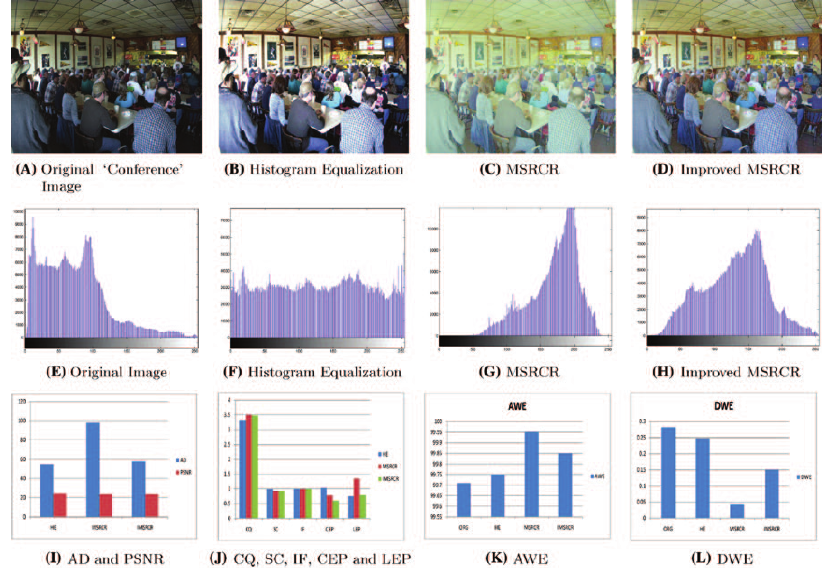
Figure 9. (Top) Image Enhancement Methods. (Middle) Histogram Plots: x -axis, Intensity Levels Ranging from 0 to 255; y -axis, Total Number of Pixels. (Bottom) Conventional Metrics and Proposed AWE and DWE Metrics. The “Conference” Image has been Downloaded from